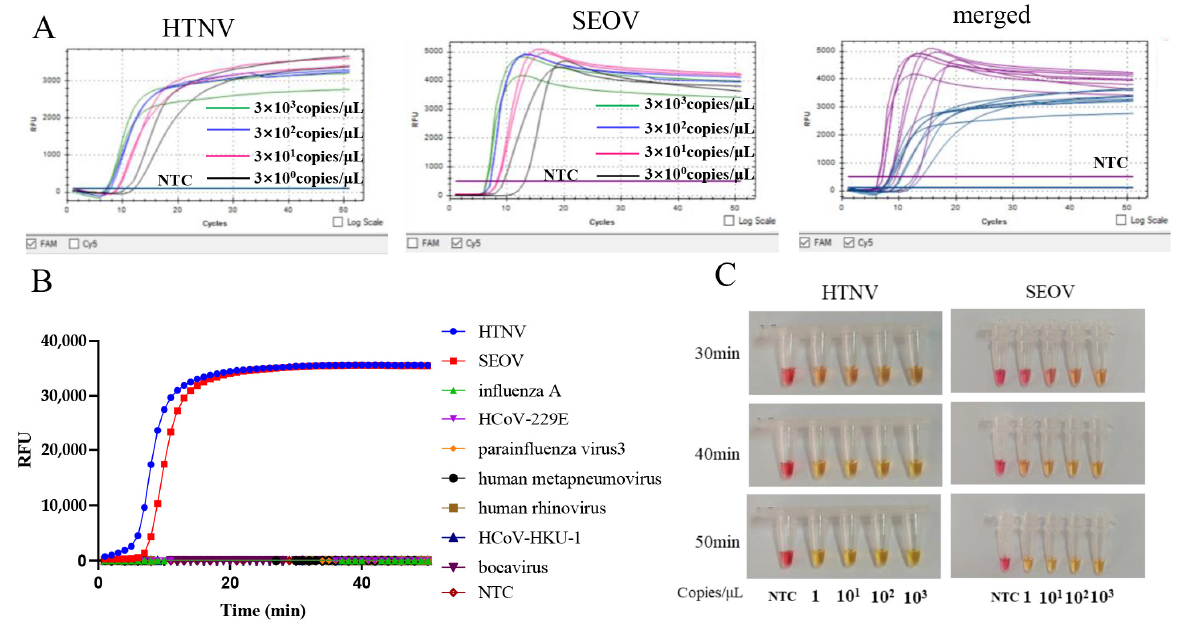
Figure 3. Sensitivity and specificity of the multiplex RT-LAMP assay. ( A ) Sensitivity. The RT-LAMP reaction was carried out with serial dilutions of 3 × 10 3 –3 × 10 0 copies/ μ L of HTNV and SEOV standard RNA. ( B ) Specificity. Tested viruses included influenza A, HCoV-229E, parainfluenza virus 3, human metapneumovirus, human rhinovirus, HCoV-HKU-1, and bocavirus. ( C ) Colorimetric reaction of the RT-LAMP assay for HTNV and SEOV. The color change from burgundy to orange or yellow was considered as positive. NTC, non-template control.